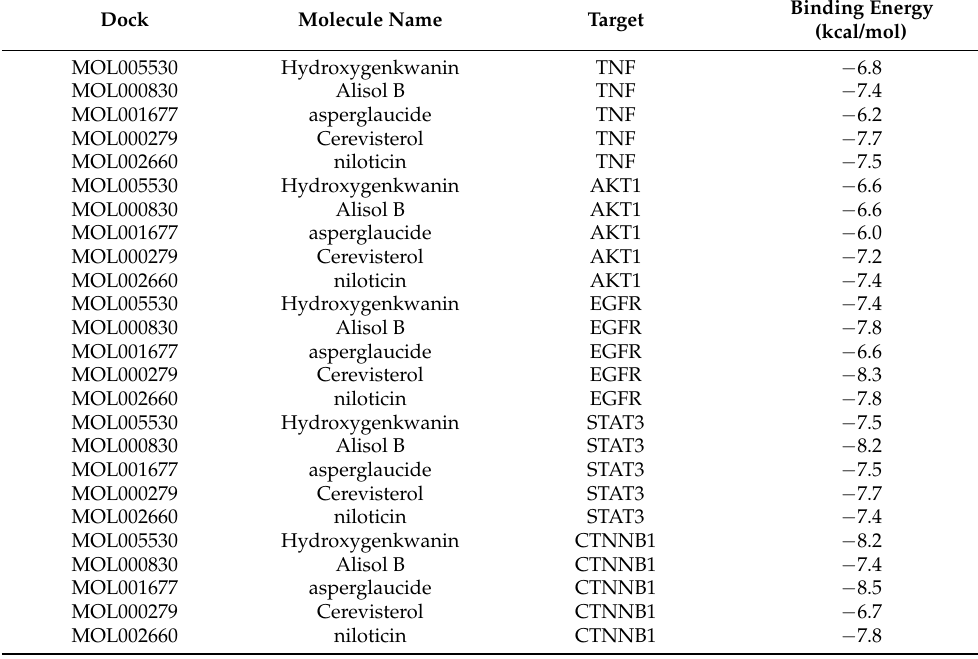
Table 2. Molecular docking results of active components and target genes of ZBDHP.